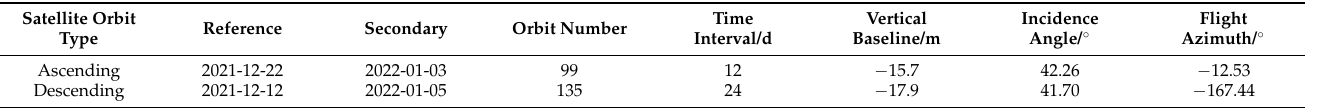
Table 2. The parameter list of Sentinel 1A satellite images before and after the Ninglang M s 5.5 earth- quake in